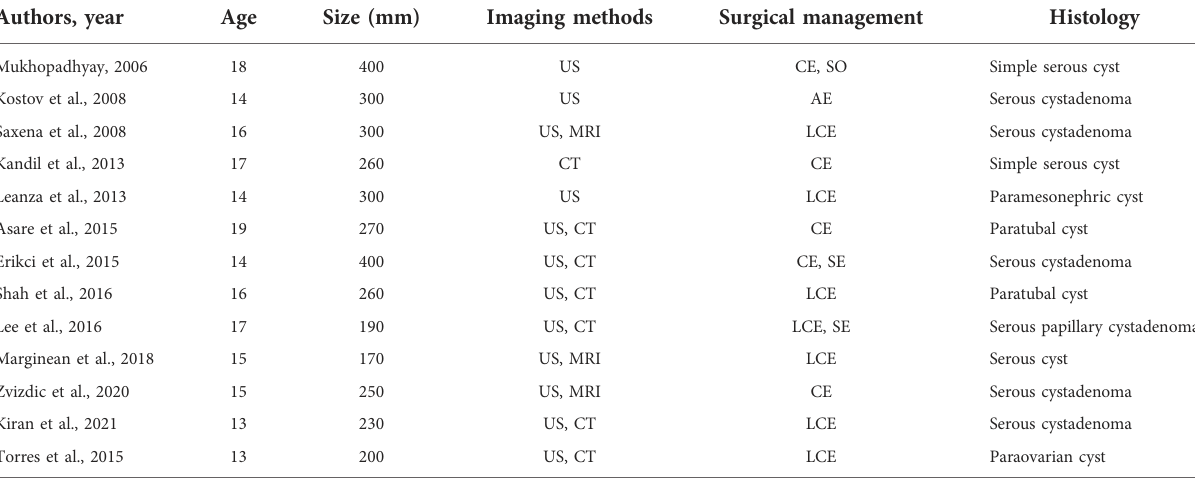
TABLE 1 Review of cases of giant paratubal cysts in the pediatric